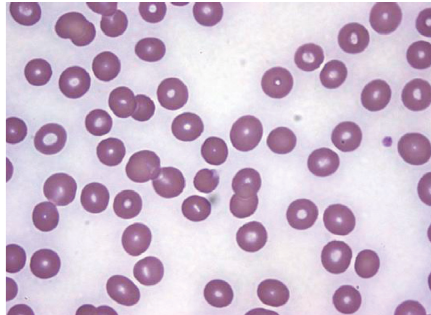
Figure 3: Peripheral thin smear noting near complete resolution of parasites four days after diagnosis. Slide prepared using Wright stain at 100X